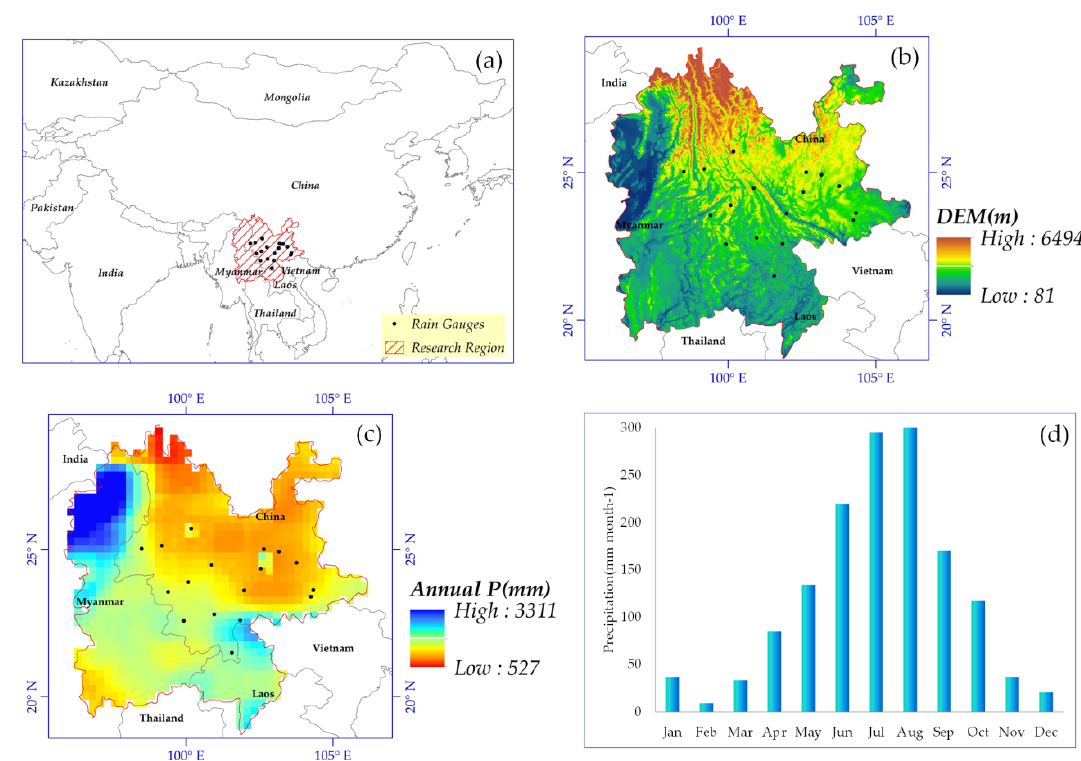
Figure 1. The geographical location of the study area ( a ) and its elevation ( b ), annual precipitation distribution ( c ), and mean monthly precipitation ( d ) from 2015 to 2018.